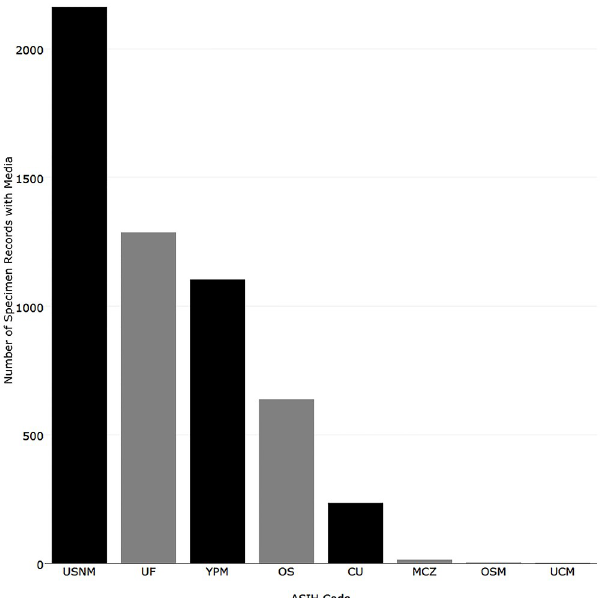
Fig 16. Number of records published in iDigBio with at least one type of media associated with a